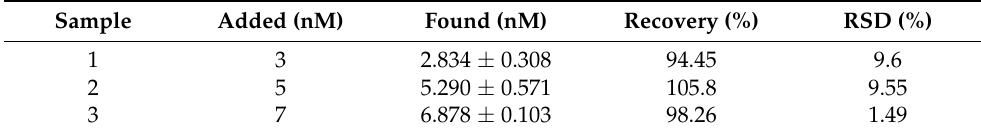
Table 2. Experimental recovery results of human serum samples (n = 3).